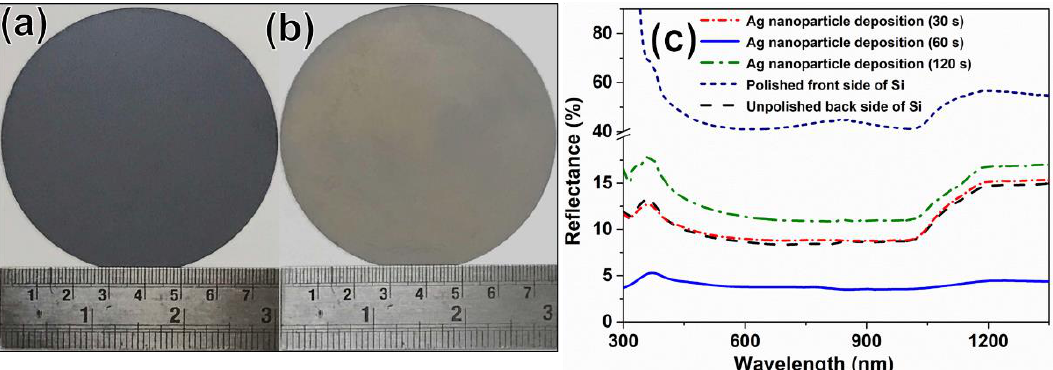
Figure 3. Digital photographs of ( a ) untreated unpolished side of Si wafer; ( b ) Ag nanoparticles deposited (60 s) on the unpolished side of Si wafer showing a significant change in color; ( c ) reflectance spectrum of the unpolished side of Si wafer with Ag nanoparticle deposition for different time intervals.